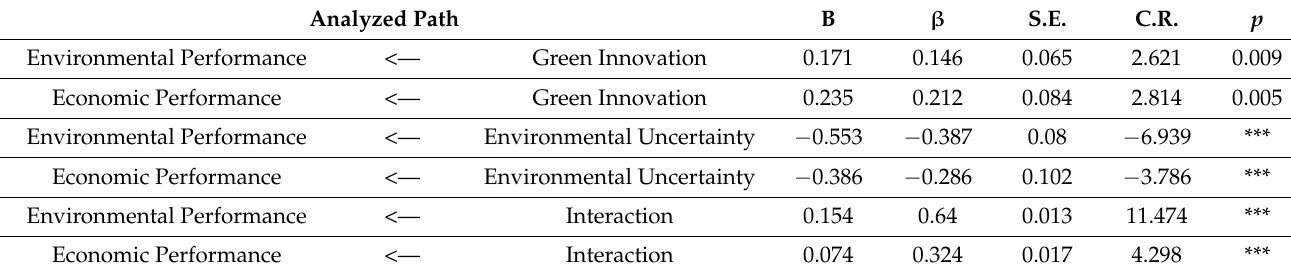
Table 7. Model regression weights.